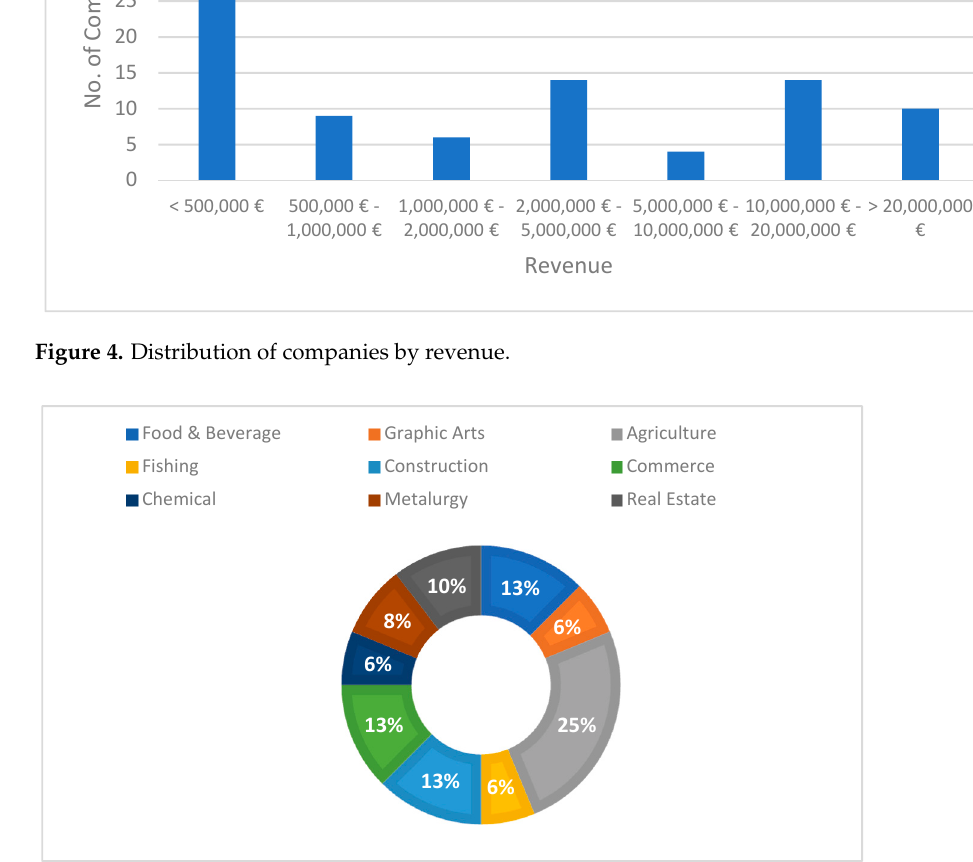
Figure 5. Distribution of companies by economic sector.